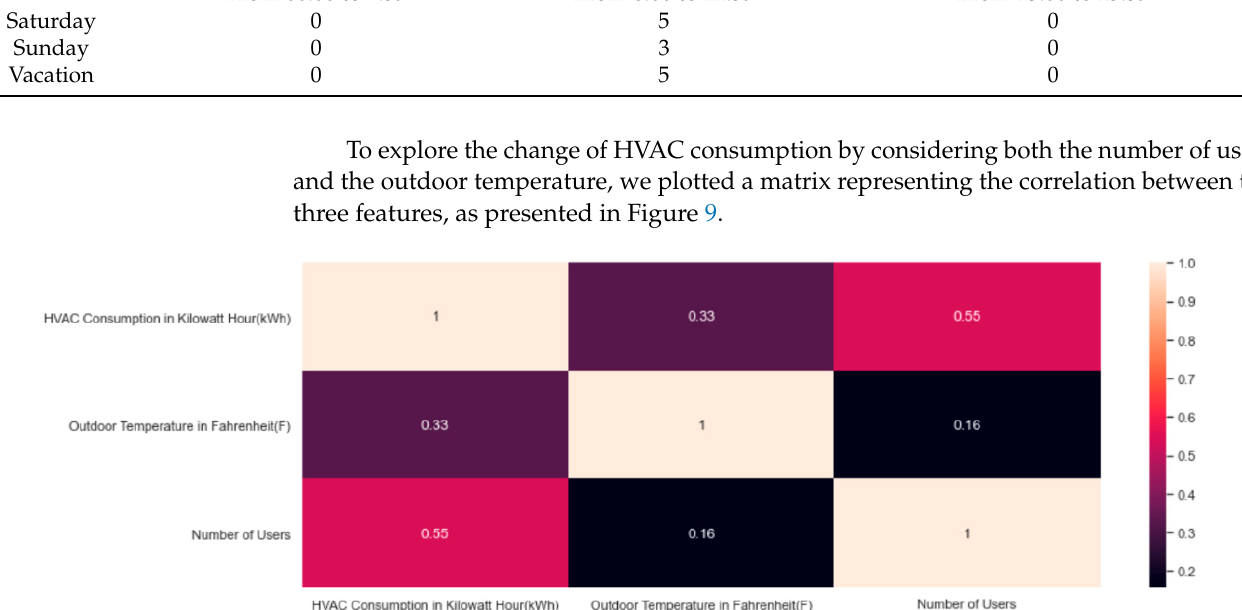
Table 2. Users distribution per hours of the day. Table 2 . Users distribution per hours of the day.